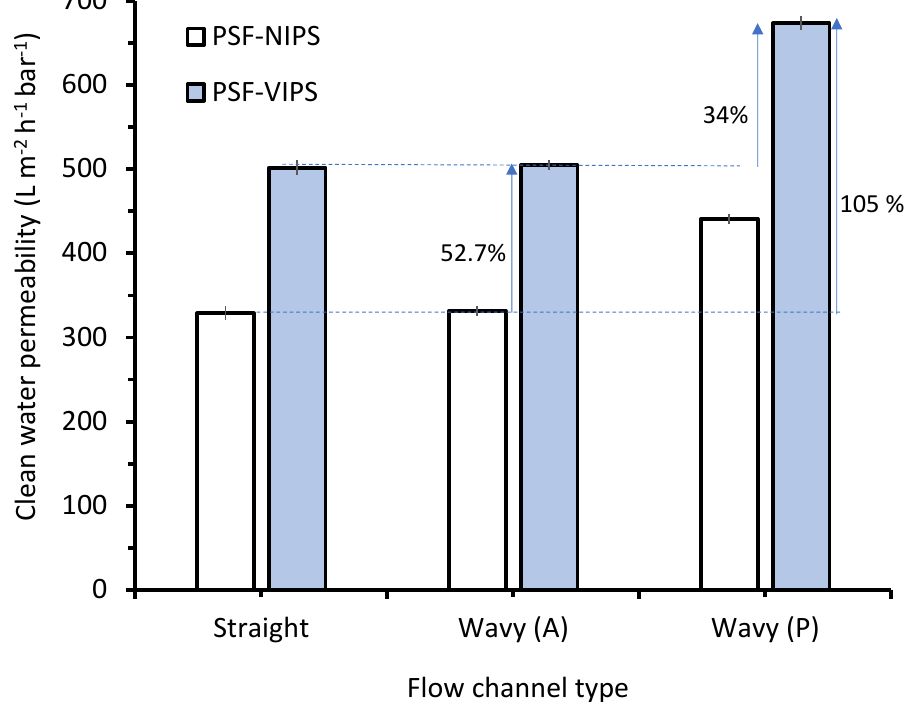
Figure 2. Effect of membrane material and feed flow channel geometry on clean water permeability. Two permeability calculations were done for the wavy channel. A represents the actual value and P represents the advantage of additional membrane area when projected to a straight flow channel.